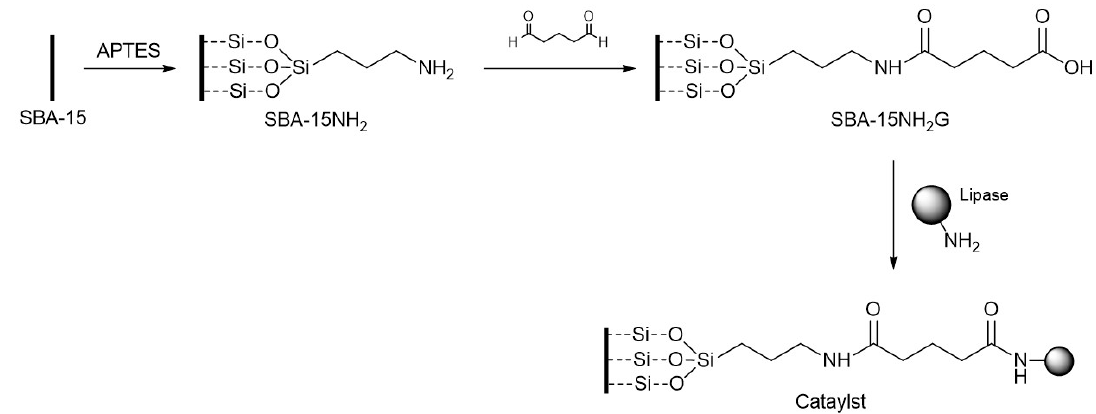
Figure 4. Synthesis of the enzymatic catalyst supported on SBA-15. Table 2. Relative peak area in the 29 Si NMR spectra.